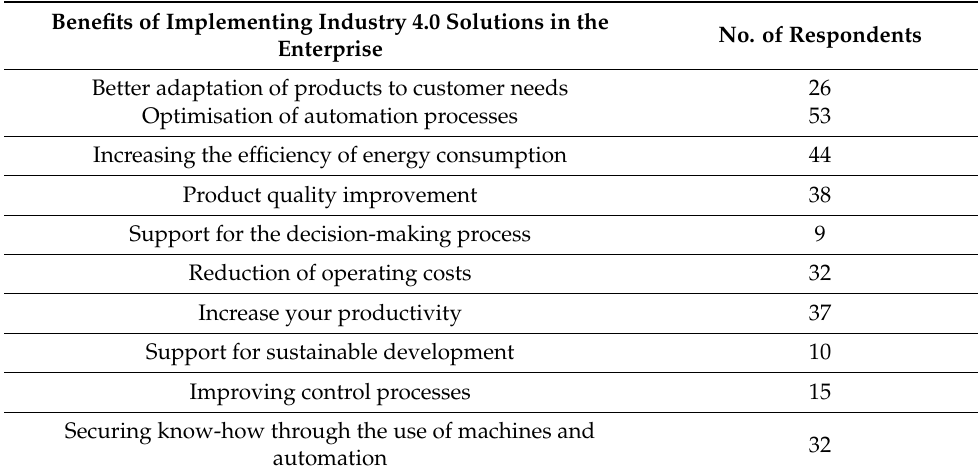
Table 8. Benefits in implementing Industry 4.0 solutions known to the